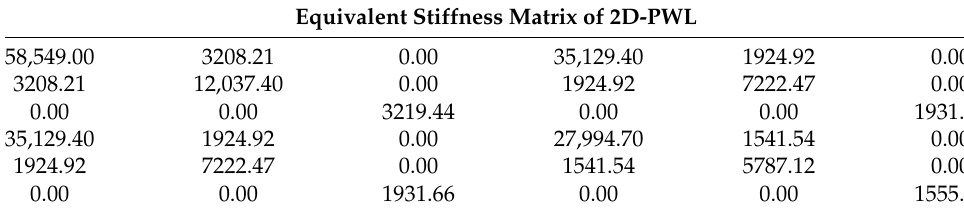
Figure 15. The 6-layered 2D plain-woven laminate. Table 13. Equivalent stiffness matrix of 2D-PWL (unit: SI).